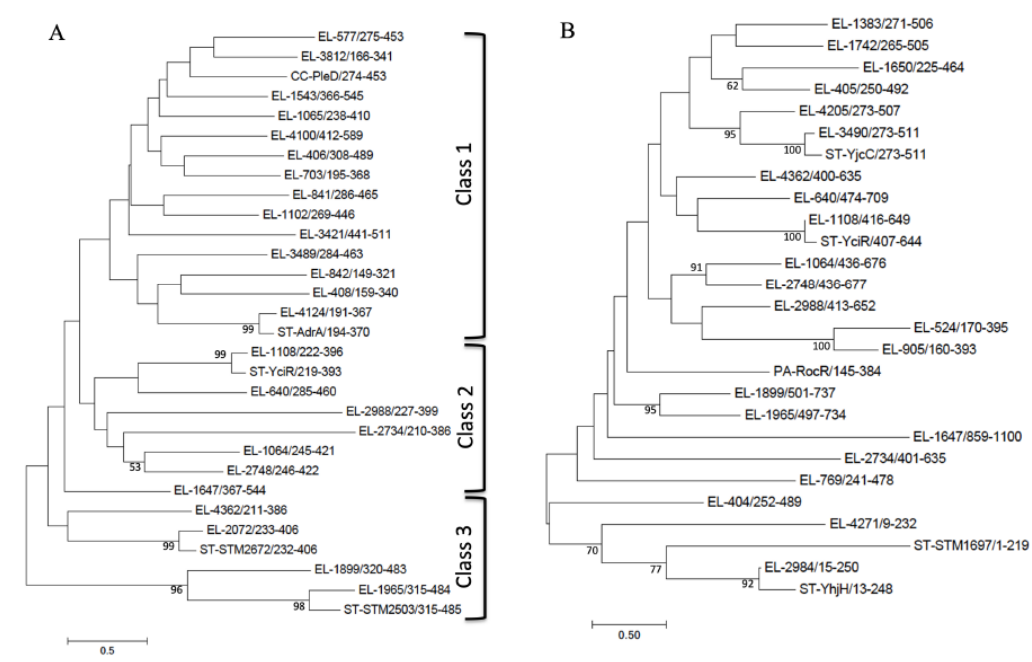
Figure 3. Phylogenetic trees of GGDEF domains ( A ) and EAL domains ( B ) in E. ludwigii CEB04. Numbers indicate amino acids of the protein included in the alignment. Bar indicates number of substitutions per site. EL = E. ludwigii , ST = Salmonella typhimurium, CC = Caulobacter crescentus and PA = Pseudomonas aeruginosa .